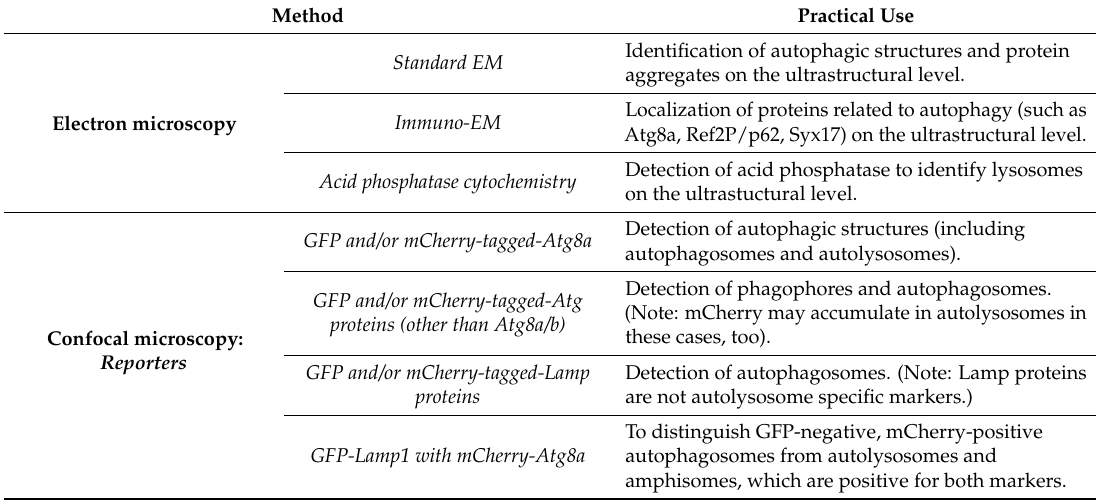
Table 1. List of methods discussed in this paper. See text for